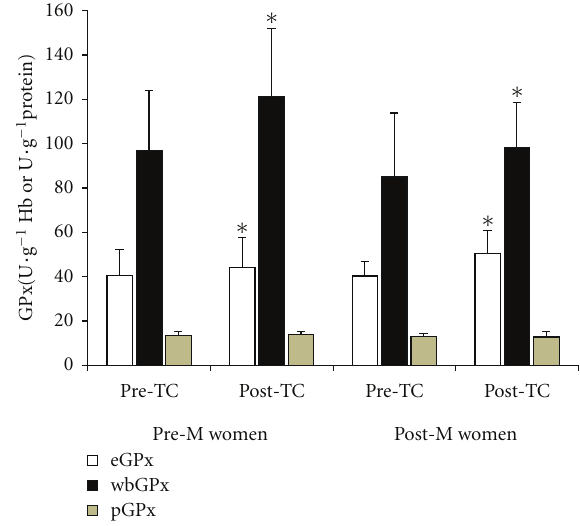
Figure 1: E ff ect of Tai Chi training on erythrocyte (eGPx, unit · g − 1 Hb), whole blood (wbGPx, unit · g − 1 Hb), and plasma (pGPx, unit · g − 1 total protein) glutathione peroxidase activities in pre-menopausal (Pre-M) and post-menopausal menopausal (Post- M) women. ∗ P < . 001, di ff erent from